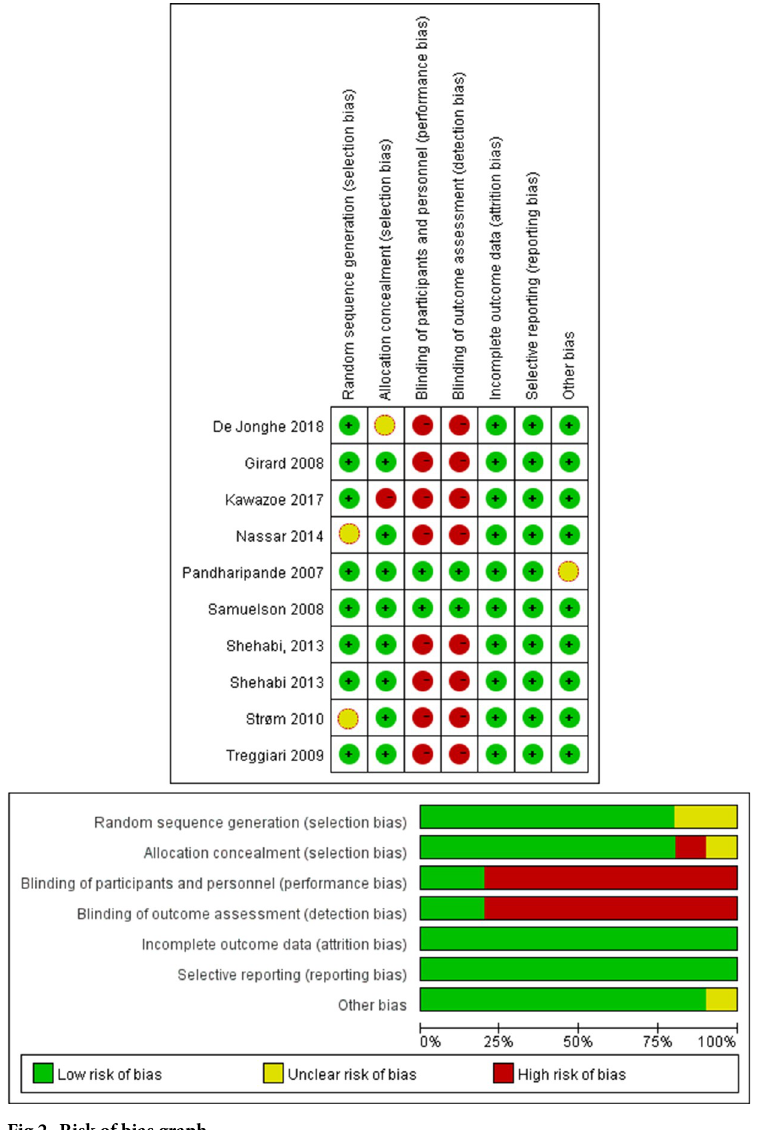
Fig 2. Risk of bias